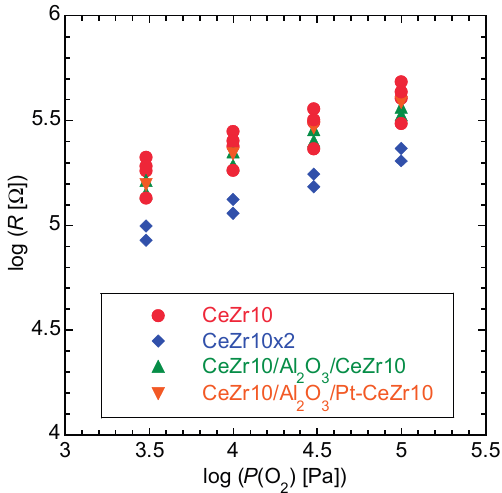
Figure 5. Resistance of CeZr10, CeZr10 × 2, CeZr10/Al 2 O 3 /CeZr10, and CeZr10/Al 2 O 3 / Pt-CeZr10 in the presence of >3%